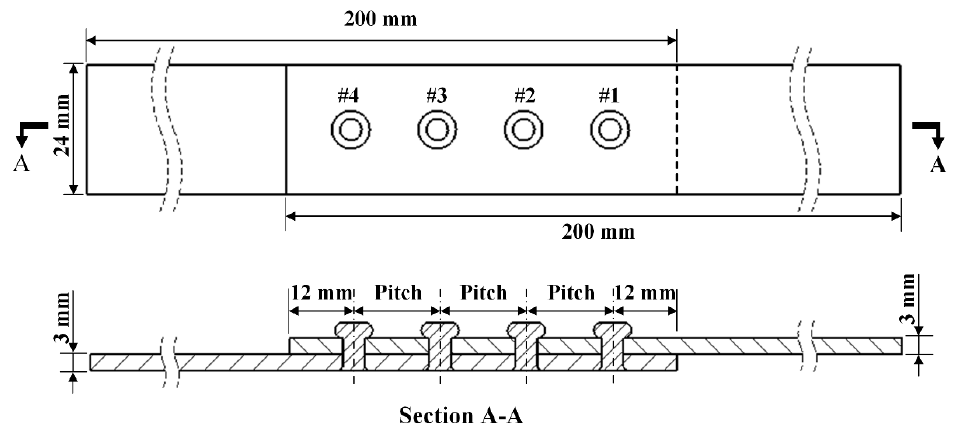
Figure 5. The structure of the riveted lap joint, the rivet diameters are set as 4 mm and 5 mm, the rivet margin is 12 mm, the rivet pitches are 16 mm, 18 mm, or 20 mm.